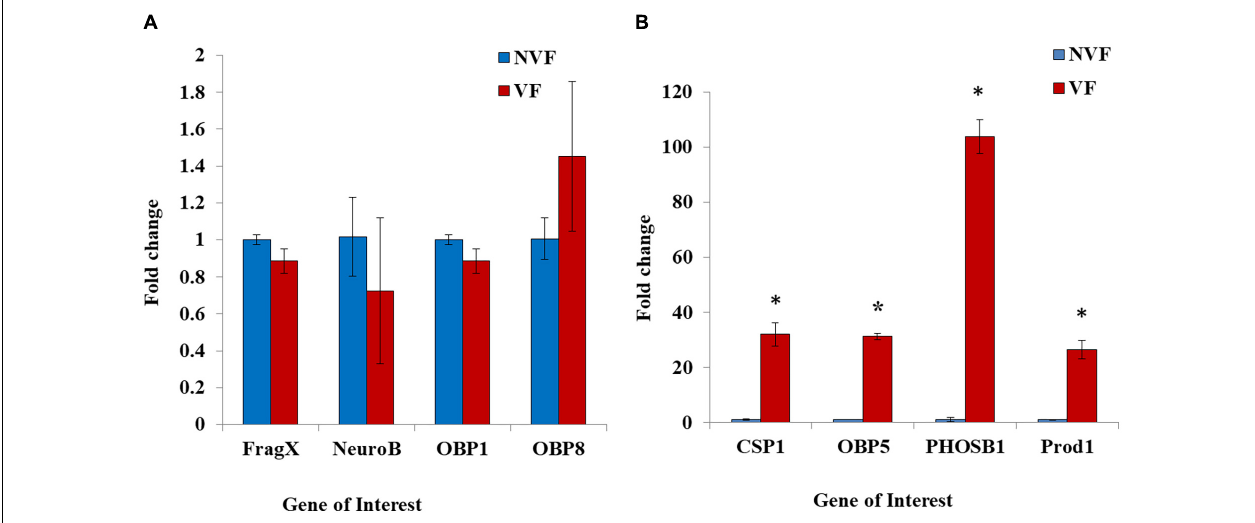
FIGURE 6 | Expression analysis of olfactory related proteins: Realtime expression analysis of OBPs was done for eight OBP related genes. Each experiment had two biological replicates with three technical replicates each. Actin and ribosomal protein 13L were used as reference genes for normalization of transcripts from viruliferous (VF- represented as red bars) and non-viruliferous (NVF- represented as blue bars) whiteflies. The expression was validated for FragileX mental retardation related protein 1 (FragX), neuropeptide Y receptor type B (NeuroB), Odorant binding protein1 (OBP1), Odorant binding protein 8 (OBP8) in (A) and Chemosensory protein 1 (CSP1), Odorant binding protein5 (OBP5), Phosphotydylethalonamine- binding protein 1 like (PhosB1), and protein D1 like (prod1) in (B) . The genes in (B) were found to be upregulated in the viruliferous whiteflies. Significance of the data was estimated by an unpaired t -test. The standard deviations (SD) were used to plot the error bars. *denotes P <